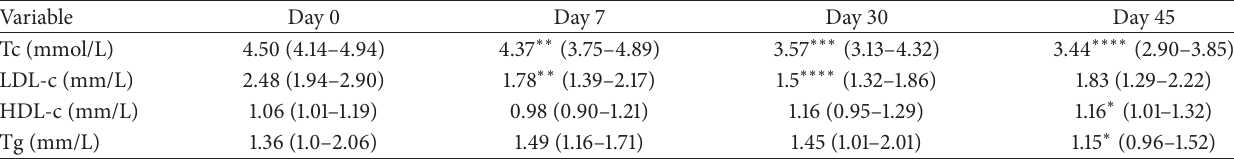
Table 1: Variation in serum lipids levels during the observational